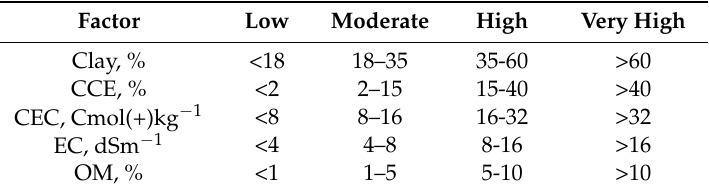
Table 3. Classification of the different KSP conditioning factors.